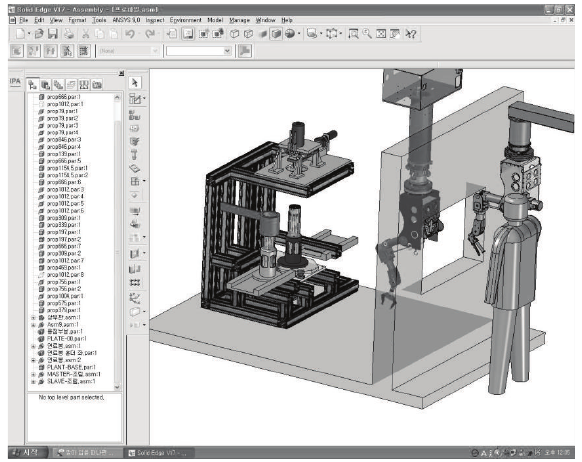
Figure 5: Schematic of remote welding system using by Pro- Engineer design method.